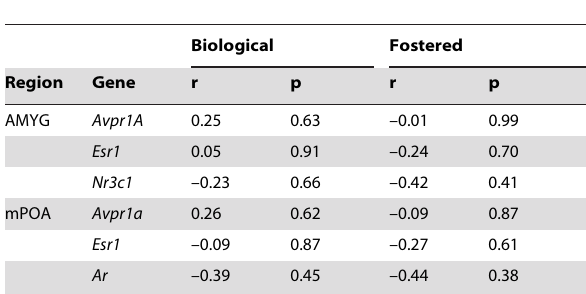
Table 2. Correlation coefficients and p-values for relative gene expression and attack latency in the 3 rd aggression trial for biologically reared (biological) and within-strain fostered (fostered) B6